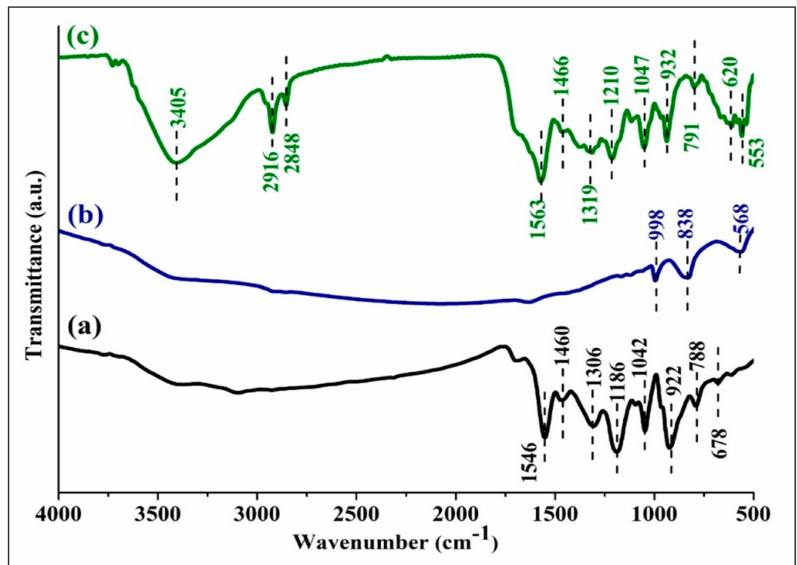
Figure 1. The Fourier transform infrared (FTIR) spectra of: ( a ) PPy, ( b ) MoS 2 and ( c ) PPy / MoS 2